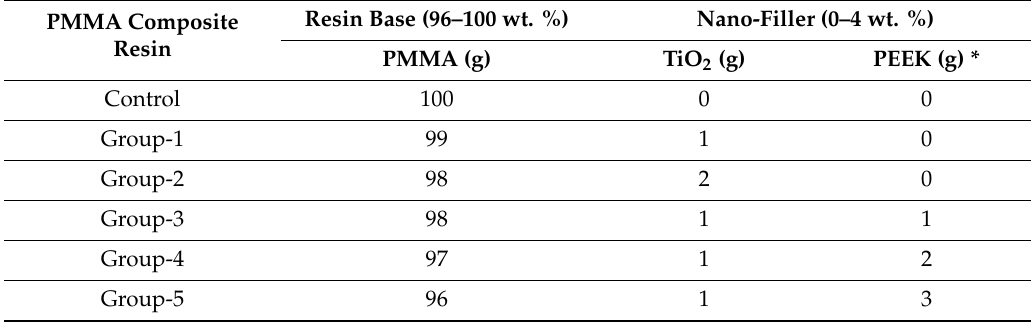
Table 1. Composition of polymethyl methacrylate (PMMA) composite resin for di ff erent groups. Resin Base (96–100 wt. %) Nano-Filler (0–4 wt. %) PMMA Composite Resin PMMA (g) TiO 2 (g) PEEK (g) * Control 100 0 0 Group-1 99 1 0 Group-2 98 2 0 Group-3 98 1 1 Group-4 97 Group-5